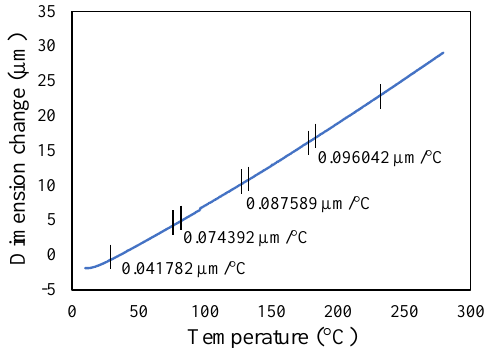
Figure 7. Thermal expansion of 0.25 mm crack depth specimen.